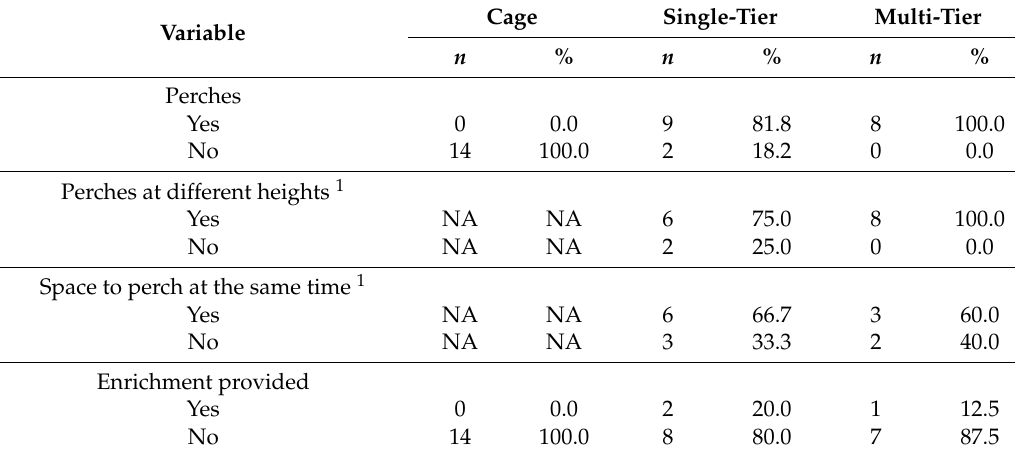
Table 2. Distribution of perches and enrichment provision for 33 pullet flocks placed between May